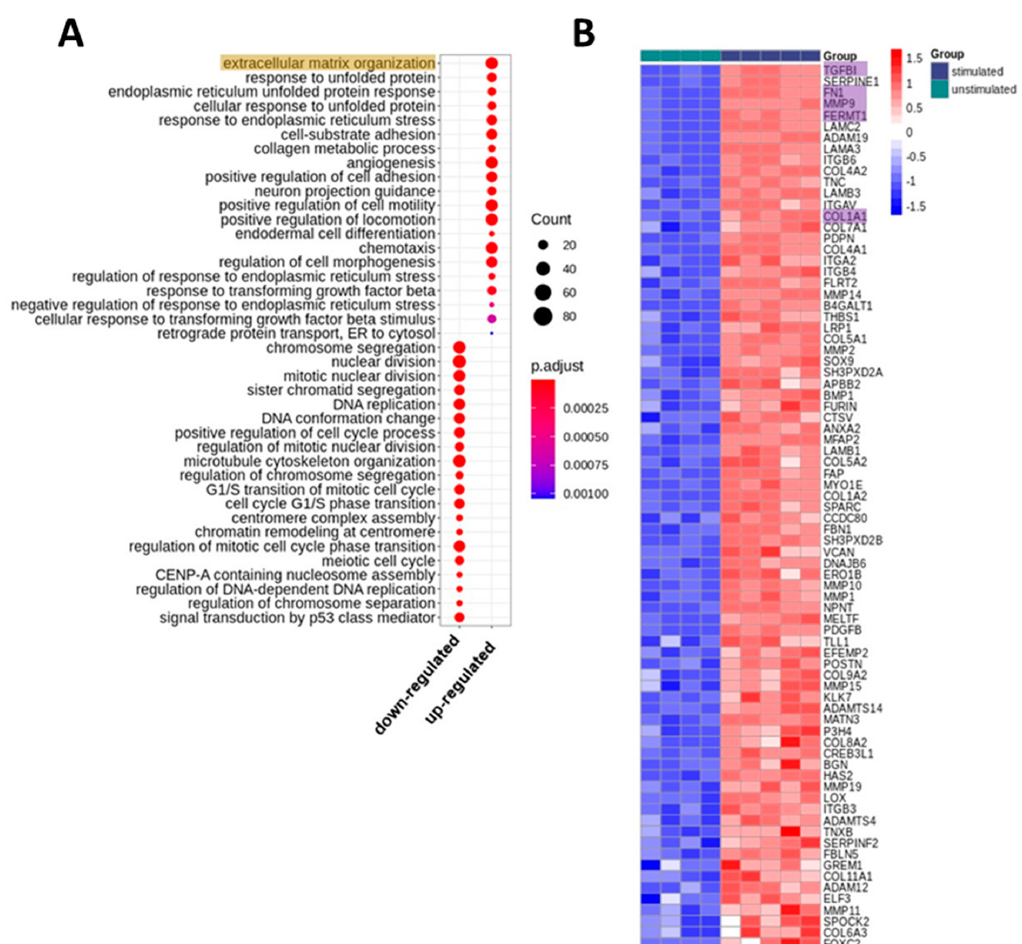
Figure 1. Transcriptomic changes in keratinocytes induced by stimulation with platelet-released growth factor (PRGF). ( A ) Gene Ontology (GO) biological processes that were enriched with genes differentially expressed in PRGF-stimulated vs. unstimulated keratinocytes. The top 20 (according to p -value) significantly enriched biological processes for up- and downregulated genes, respectively, are shown. The size of the dots displays the number of differentially expressed genes among the particular biological process. The color displays the adjusted p -values. ( B ) Heatmap of genes differentially expressed in stimulated vs. unstimulated keratinocytes from the top enriched GO biological process “extracellular matrix organization.” The color code displays row Z-score. The genes are ordered by log2 fold change and expression level over all samples, that is, the top genes revealed high log2 fold changes together with high expression. The expression of the highlighted genes was further analyzed in detail (see below).